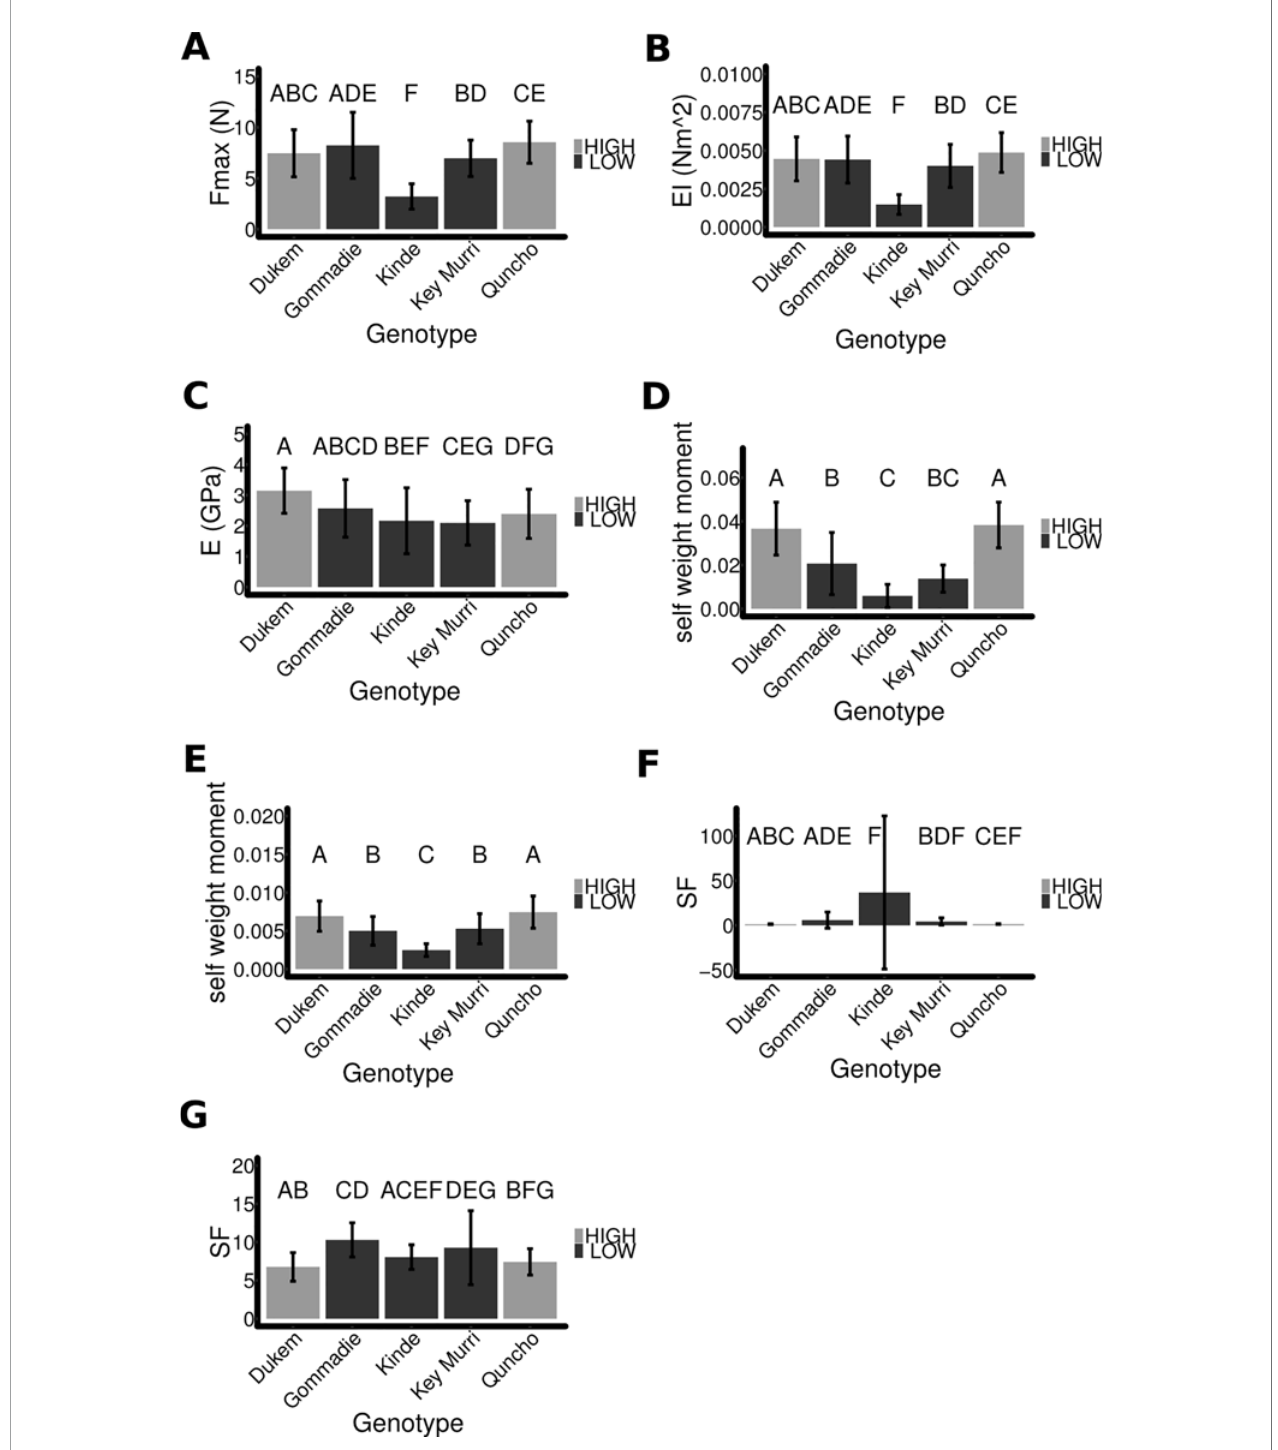
FIGURE 3 | A comparison of the different mechanical properties of the tef ecotypes. (A) The breaking force of the fi rst internode is shown. (B) The fl exural rigidity was extracted from the three-point bending experiments. (C) The Young's modulus does not differ signi fi cantly between the high and low lodging ecotypes. (D , E) The self-weight moment of each ecotype was computed using (D) the measured angle and assuming (E) and angle of 10° for all species. (F) The safety factor of each ecotype was computed from the breaking force and the self-weight of the stem. The fi nal angle of the mature stem was used. (G) The safety factor was computed assuming that all genotypes had the same angle of 10°. The same letter denotes means that are not signi fi cantly different with p > = 0.05 and determined using ANOVA, Tukey